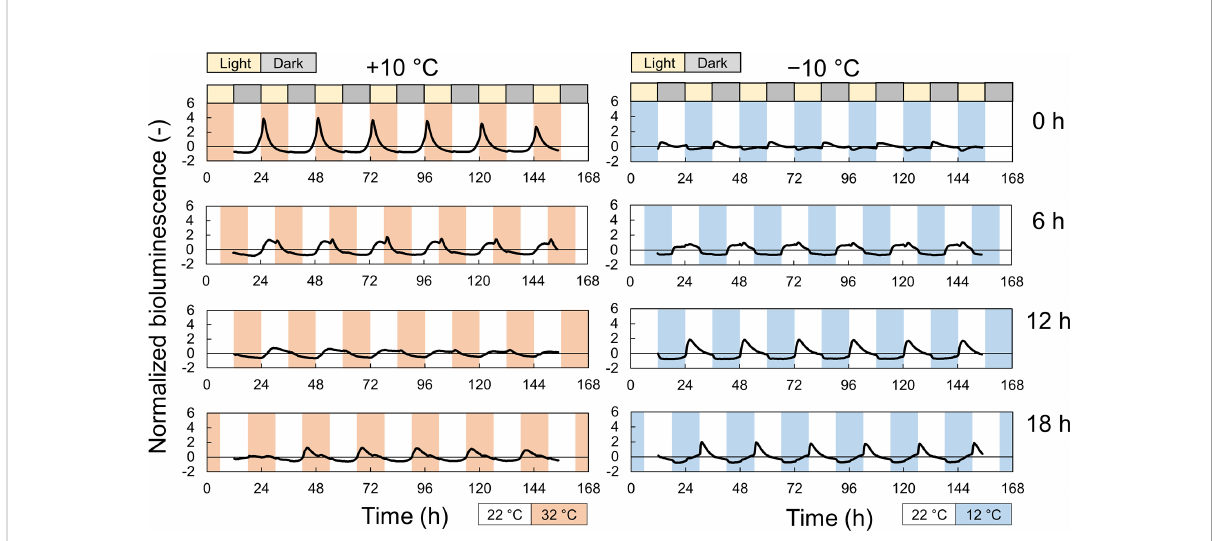
FIGURE 3 Normalized bioluminescence of AtCCA1 :: LUC in Lactuca sativa L. ‘ Cos ’ under the light and ±10°C temperature cycles with different time lags during an experiment to investigate the effect of time lags in light: dark and temperature cycles during cultivation. Photoperiod is L/D = 12/12 h. Periodic temperature stimuli (+10°C [orange] or − 10°C [blue] from 22°C for 12 h within a 24-h period) were applied with four time-lags ( D t = 0, 6, 12, and 18 h after turning on the light). Each data is the average of 7